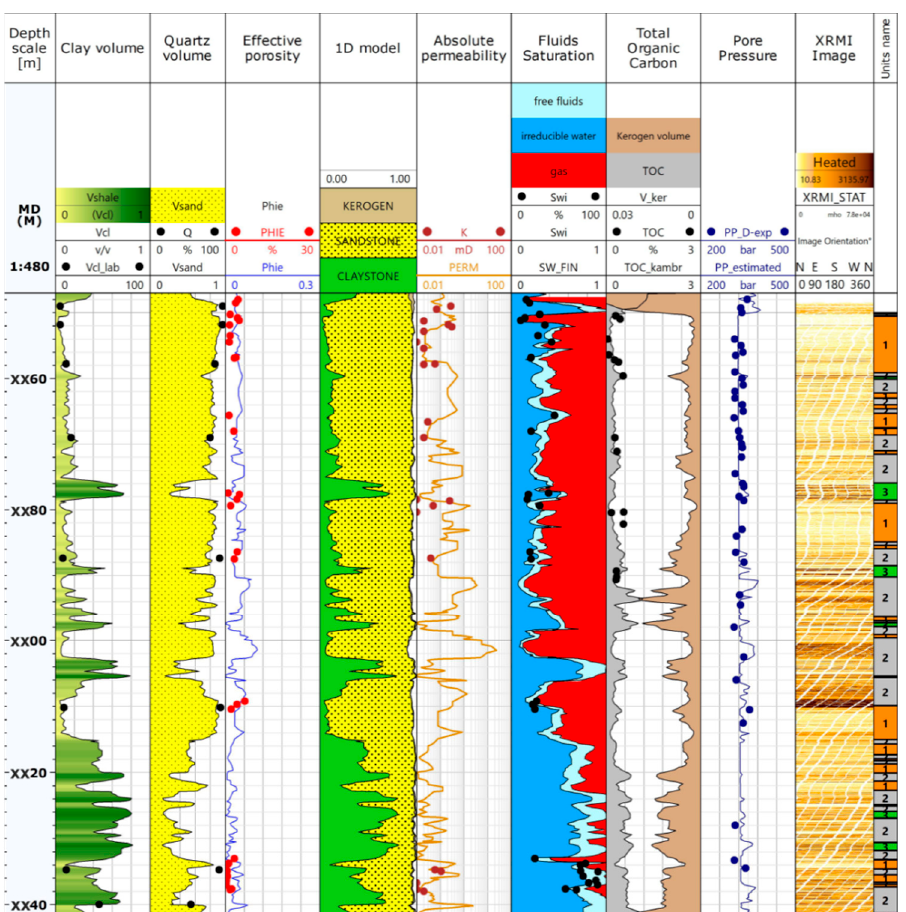
Figure 7. Geomechanical and petrophysical properties of the Middle Cambrian reservoir calculated from well logs and calibrated with laboratory measurements in well W ‐ 2.